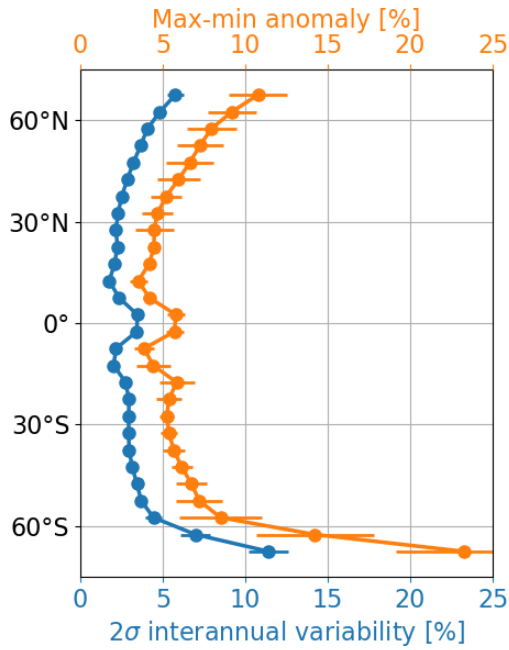
Figure 4. Interannual variability (%) in total ozone as a func- tion of latitude derived from the GTO-ECV data record. The blue curve signifies 2 times the standard deviation of the yearly ozone anomalies based on the reference period 1997–2020, and the orange curve signifies the corresponding range (maximum–minimum) of the anomaly. The error bars signify the variation in the variability with